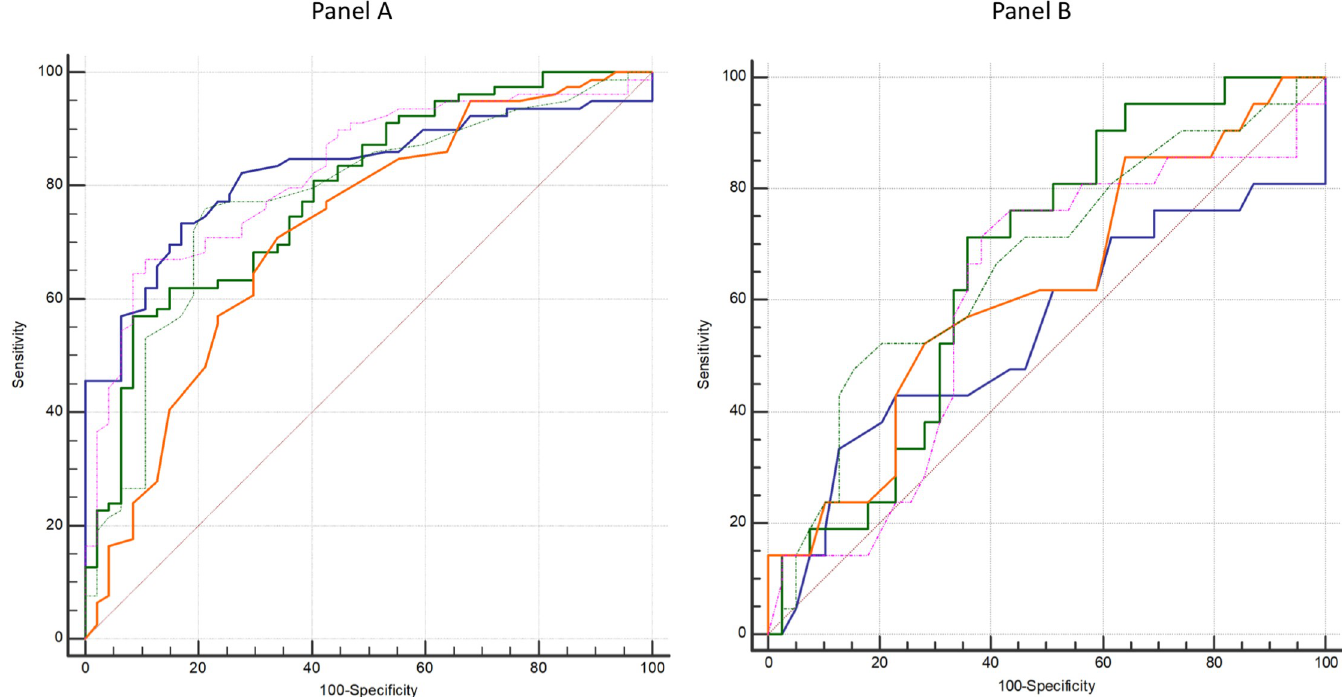
Fig 2. ROC curves of the different tests to diagnose arterial stenosis � 50% in the overall population ( n = 126 limbs ) (A) and in the population with an ABI > 0.91 ( n = 60 limbs ) (B). Blue curve is ABI; Green curve post exercise ABI decrease; Orange post-exercise ankle pressure decrease; Green curve (incomplete line) exercise TcPO2 (DROP); Pink curve: post-exercise ABI.